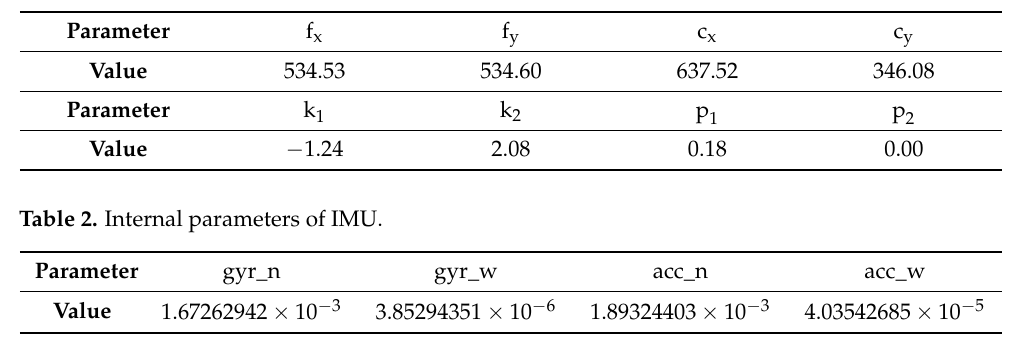
Table 1. Internal parameters of ZED 2i’s left camera.